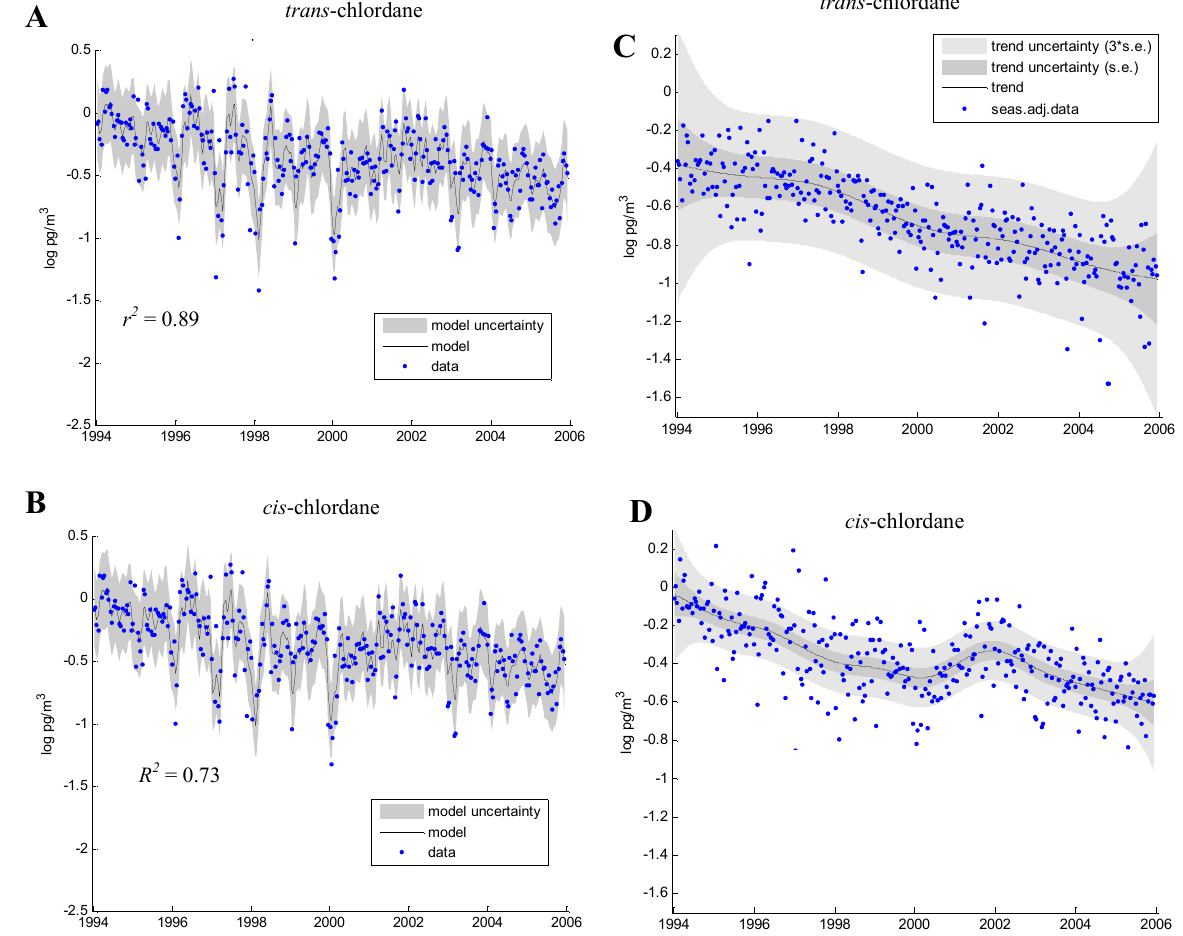
Fig. 1. Measured data and model fit for trans- chlordane (A) and cis- chlordane (B) with goodness of fit between observed data and model fit expressed by the r 2 value ( p < 0 . 05). Seasonally adjusted data and underlying trends are provided in plots (C) ( trans- chlordane) and (D) ( cis-